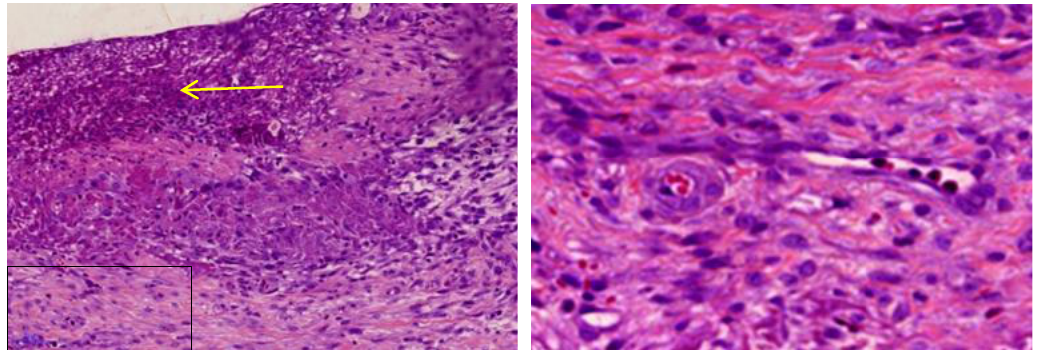
Figure 4: Microphotograph of study group treated with gingival sulcular irrigation of 50 μL/kg of distilled water after seven days showing mild inflammatory cell, ulcerative sulcular epithelium (arrow). H&E x20, x40.